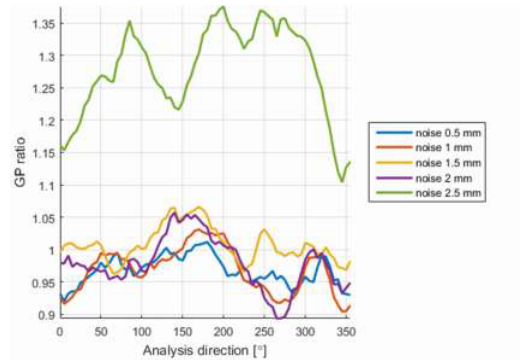
Figure 5. GP ratio for the denoised grids of 5 mm.